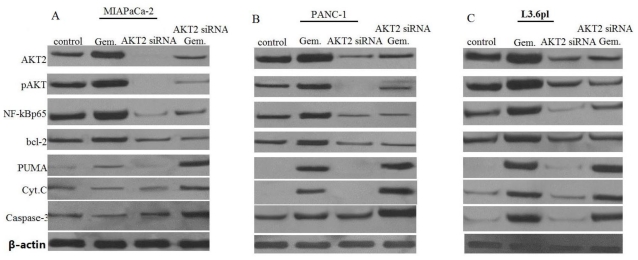
Western blotting analysis of the effect of rAAV2-AKT2 siRNA in combination with gemcitabine treatment on levels of PUMA and its downstream targets, NF-κBp65 and its downstream targets bcl-2, AKT2 and pAKT in established tumors after 6 weeks treatment. (A,B) In MIAPaCa-2 and PANC-1 established tumors, rAAV2-AKT2 siRNA combined with gemcitabine significantly decreased NF-κB expression and increased expression of PUMA and its downstream targets compared with control tumors; (C) Treatment with rAAV2-AKT2 siRNA combined with gemcitabine did not increase the levels of PUMA and its downstream targets compared with gemcitabine treatment alone in L3.6pl cells. However, there was a decrease in NF-κB expression in L3.6pl established tumors treated with rAAV2-AKT2 siRNA combined with gemcitabine.